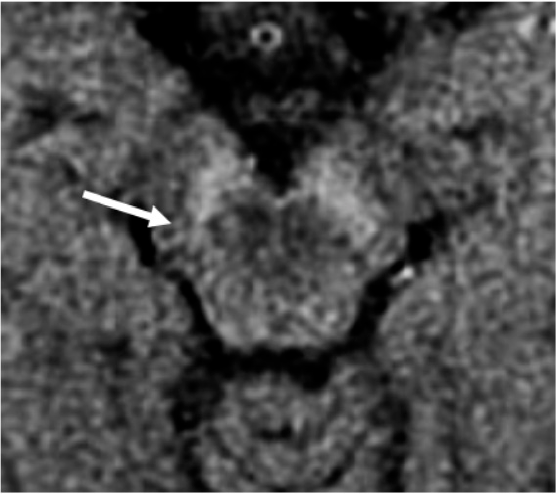
Figure 2. NM-MRI sequence with an explicit MT preparation pulse, scanned with a 1.5T MR scanner at the level of the SN in a PD patient with asymmetrical motor symptoms onset: the loss of hyper- intensity in the posterolateral aspect of the right SN (arrow) correlated well with the clinical presen- tation.